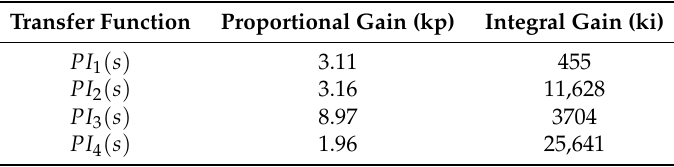
Table 1. Voltage controllers’